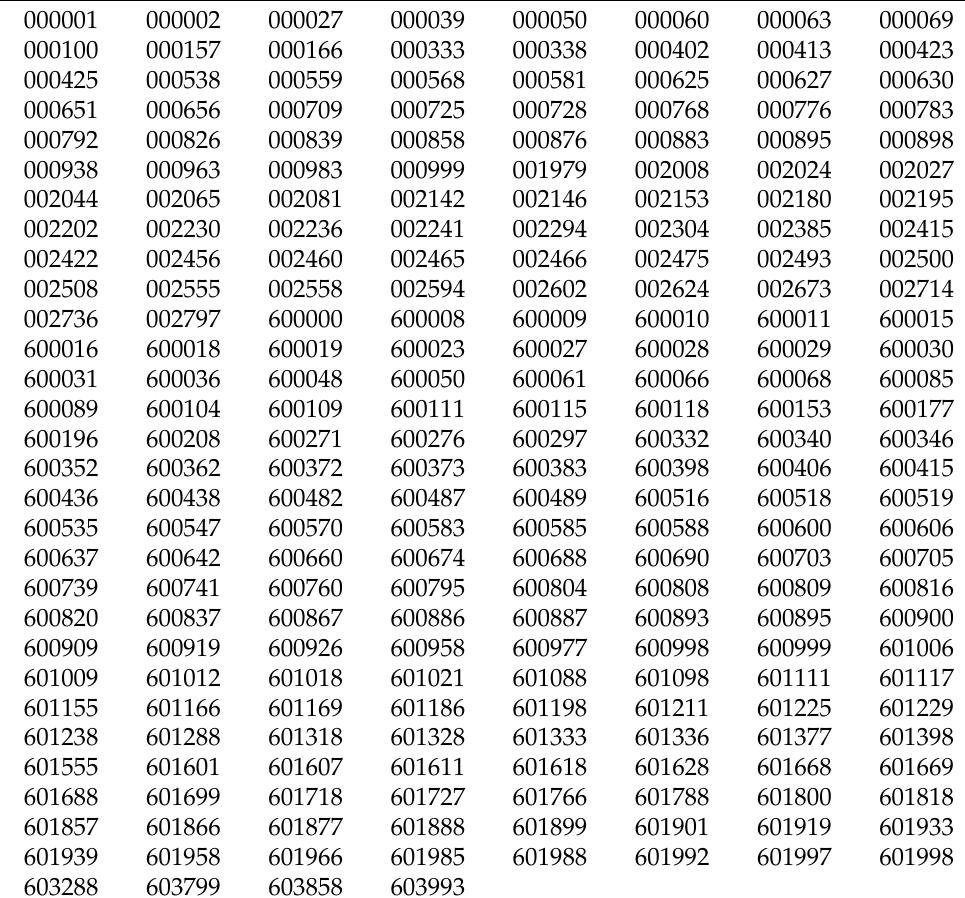
Table 1. Codes of MSCI China A-shares in the Chinese Stock